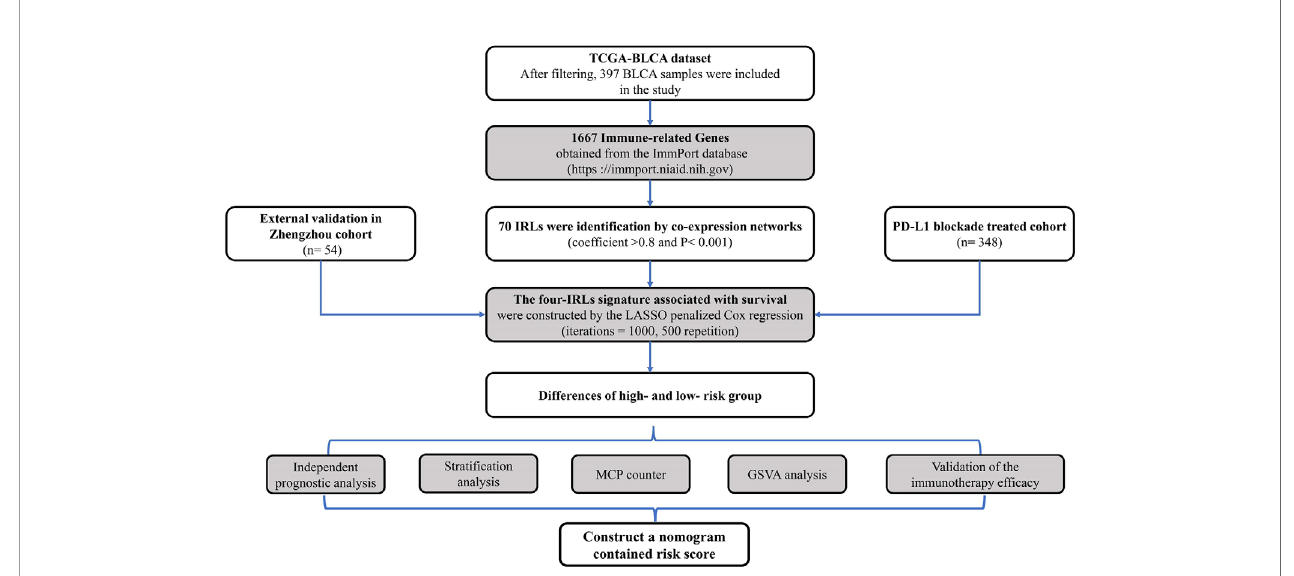
FIGURE 1 | The fl owchart describes the construction and validation of